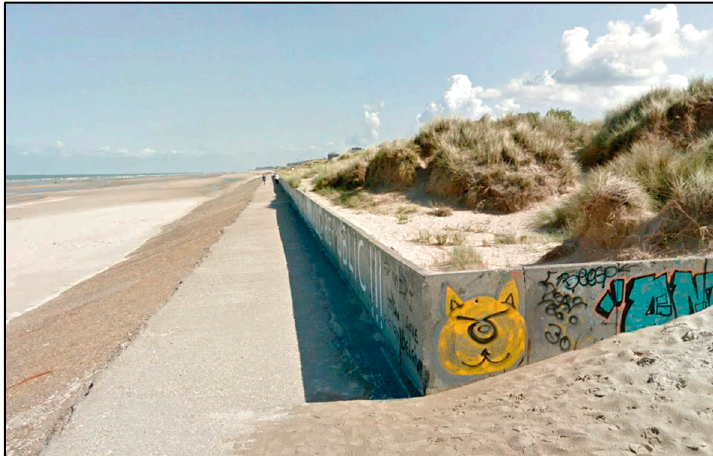
Figure 13. Concrete revetment and wall, built to reinforce the dune foot in section 8.